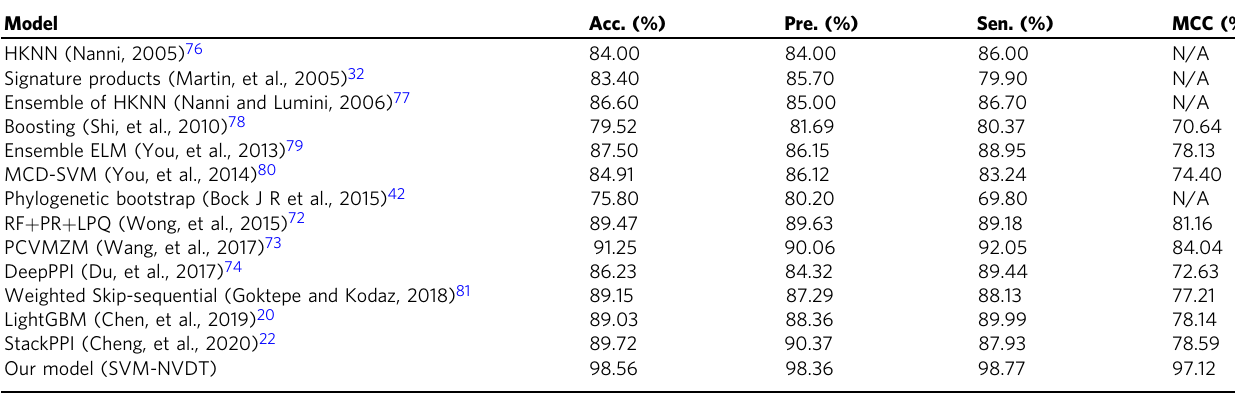
Table 6 Comparison of existing methods using the H. pylori dataset. Model